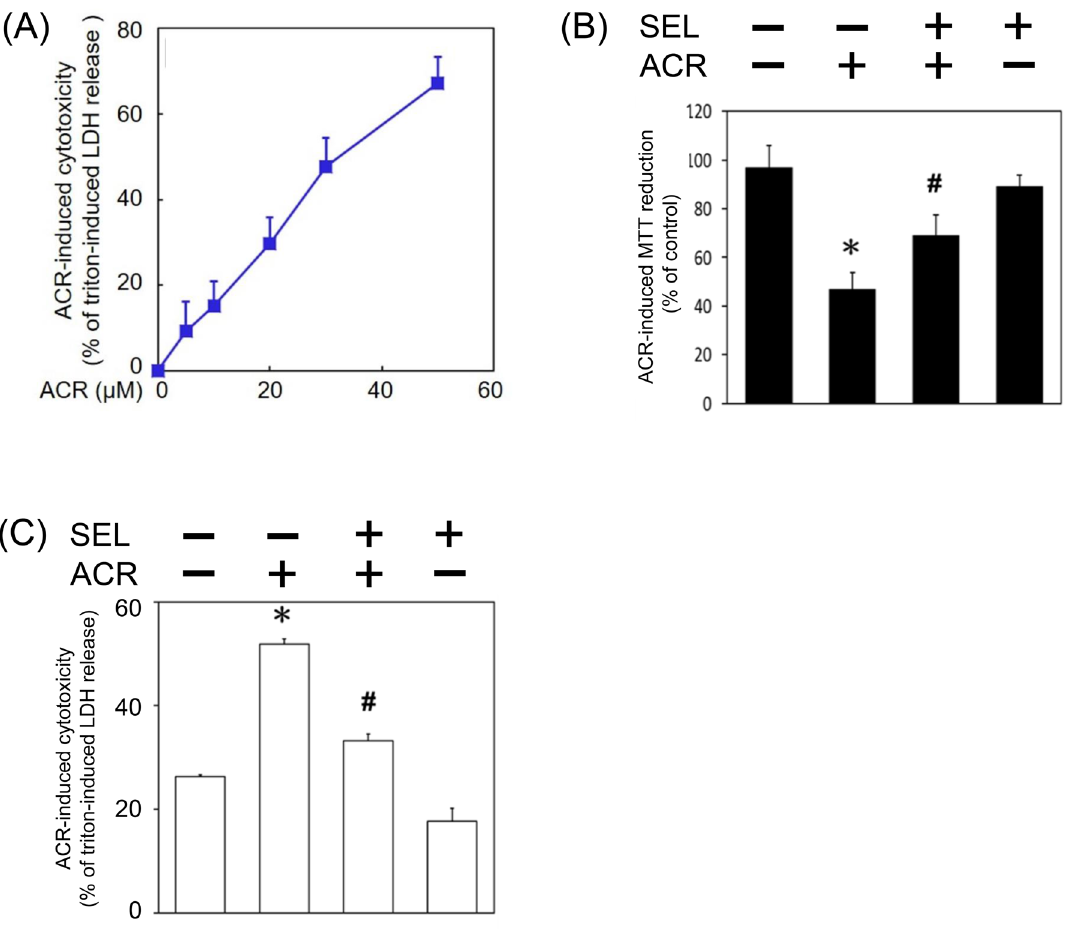
Figure 5. Effect of selumetinib on acrolein-induced cytotoxicity. ( A ) Primary cultured cortical neurons (5 × 10 6 cells /well) in a 24-well plate were treated with acrolein (0–50 μM) for 24 h. Cell death was measured with LDH assay. Values are the mean ± SEM (n = 3/group). *p < 0.05, statistically significant in the acrolein groups compared with the control groups by t test. ( B , C ) Primary cultured cortical neurons were treated with acrolein (30 μM) with/without selumetinib (SEL, 10 μM) for 24 h. Cell viability was measured using MTT assay ( B ) and cell death using LDH assay ( C ), respectively. Values are the mean ± SEM (n = 3/group). *p < 0.05 statistically significant in the acrolein groups compared with the control groups; # p < 0.05 statistically significant in acrolein plus SEL group compared with acrolein group by one-way analysis of variance (one-way ANOVA) and followed by the LSD test as post-hoc